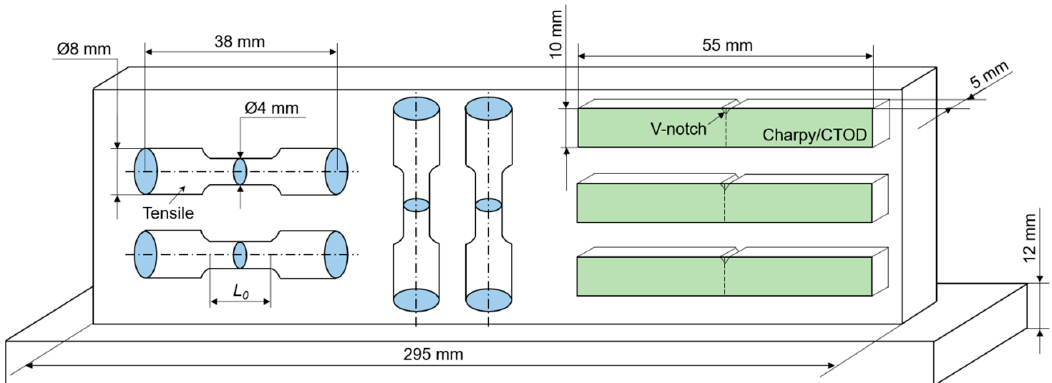
Figure 1. Schematic illustration of additive manufacturing of component.